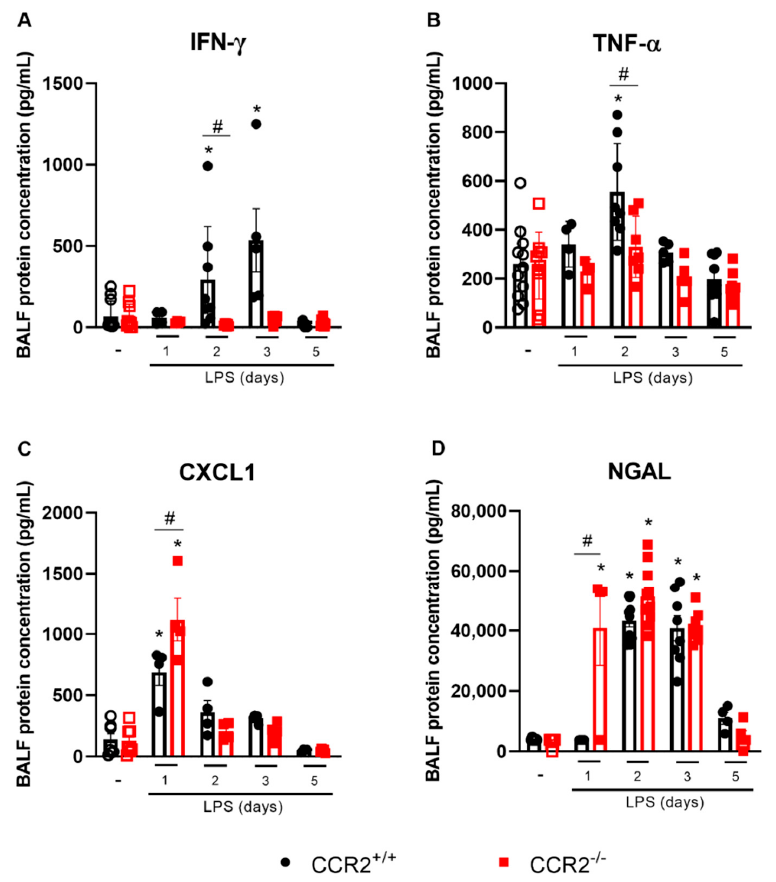
Figure 2. CCR2 deficiency affects cytokine levels in the pro-inflammatory phase of the inflammation. CCR2 +/+ (black symbols) and CCR2 − / − (red symbols) C57BL/6 mice were challenged with LPS (12.5 µg/mouse) or PBS (ctrl group; -) intranasally and dissected at the indicated days. Levels of IFN- γ ( A ), TNF- α ( B ), CXCL1 ( C ), and NGAL ( D ) were measured in the BALF by ELISA. Compilation of three experiments. Data are shown as mean ± SEM. Each symbol represents data of an individual mouse. * p < 0.05 when compared with the healthy, unchallenged control group. # p <